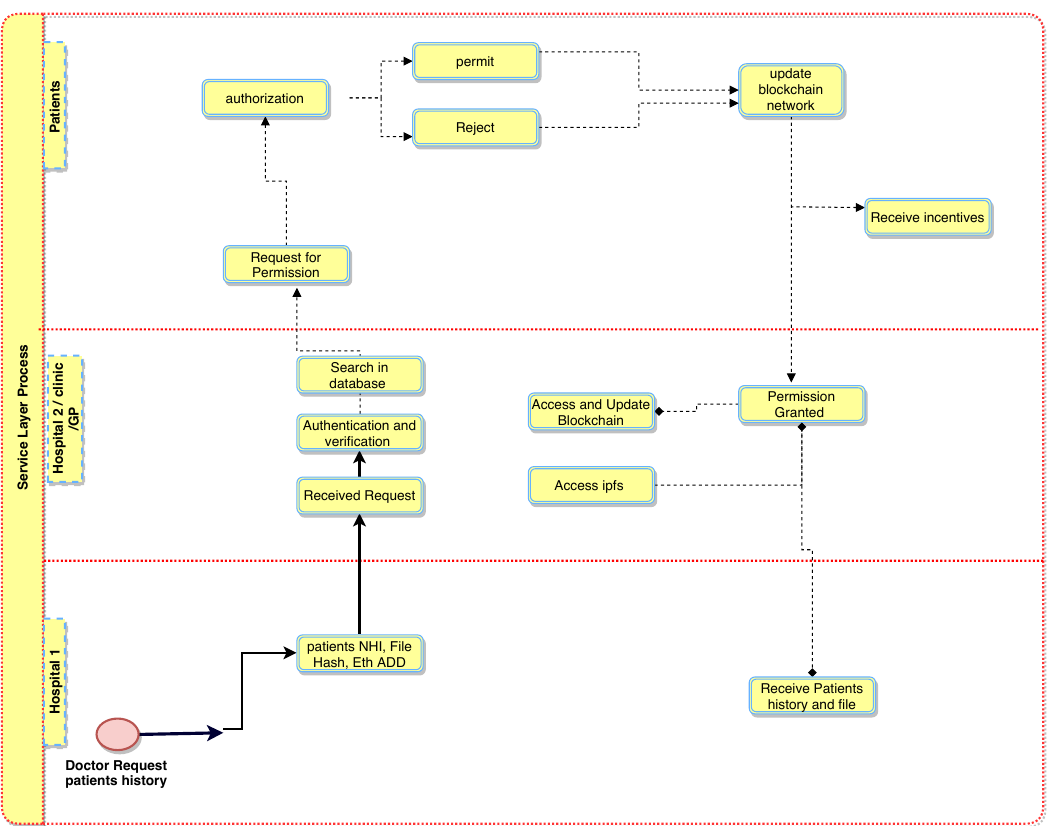
Figure 6. BlockPres service layer processes.